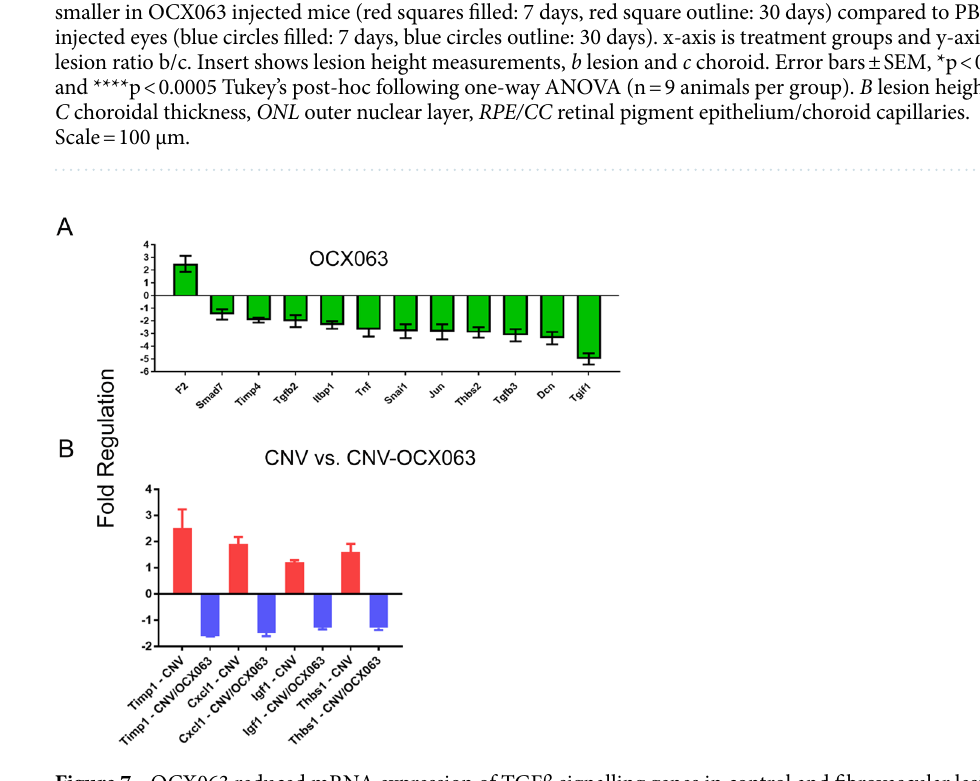
Figure 7. OCX063 reduced mRNA expression of TGFβ signalling genes in control and fibrovascular lesion size 7-days and 30-days following laser induced CNV. ( A ) Bar graph of OCX063 regulated gene in non-lasered RPE/ choroid (green). ( B ) Bar graph of regulated genes in OCX063 regulated genes in lasered RPE/choroid (blue) compared to lasered RPE/choroid (red). x-axis genes ranked by fold change positive to negative and y-axis is fold change. n = 9 animals per